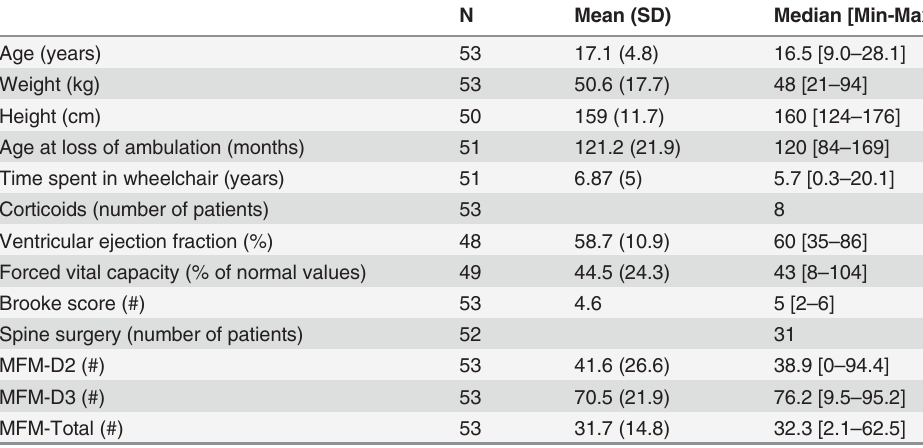
Table 2. Clinical and functional data at baseline.